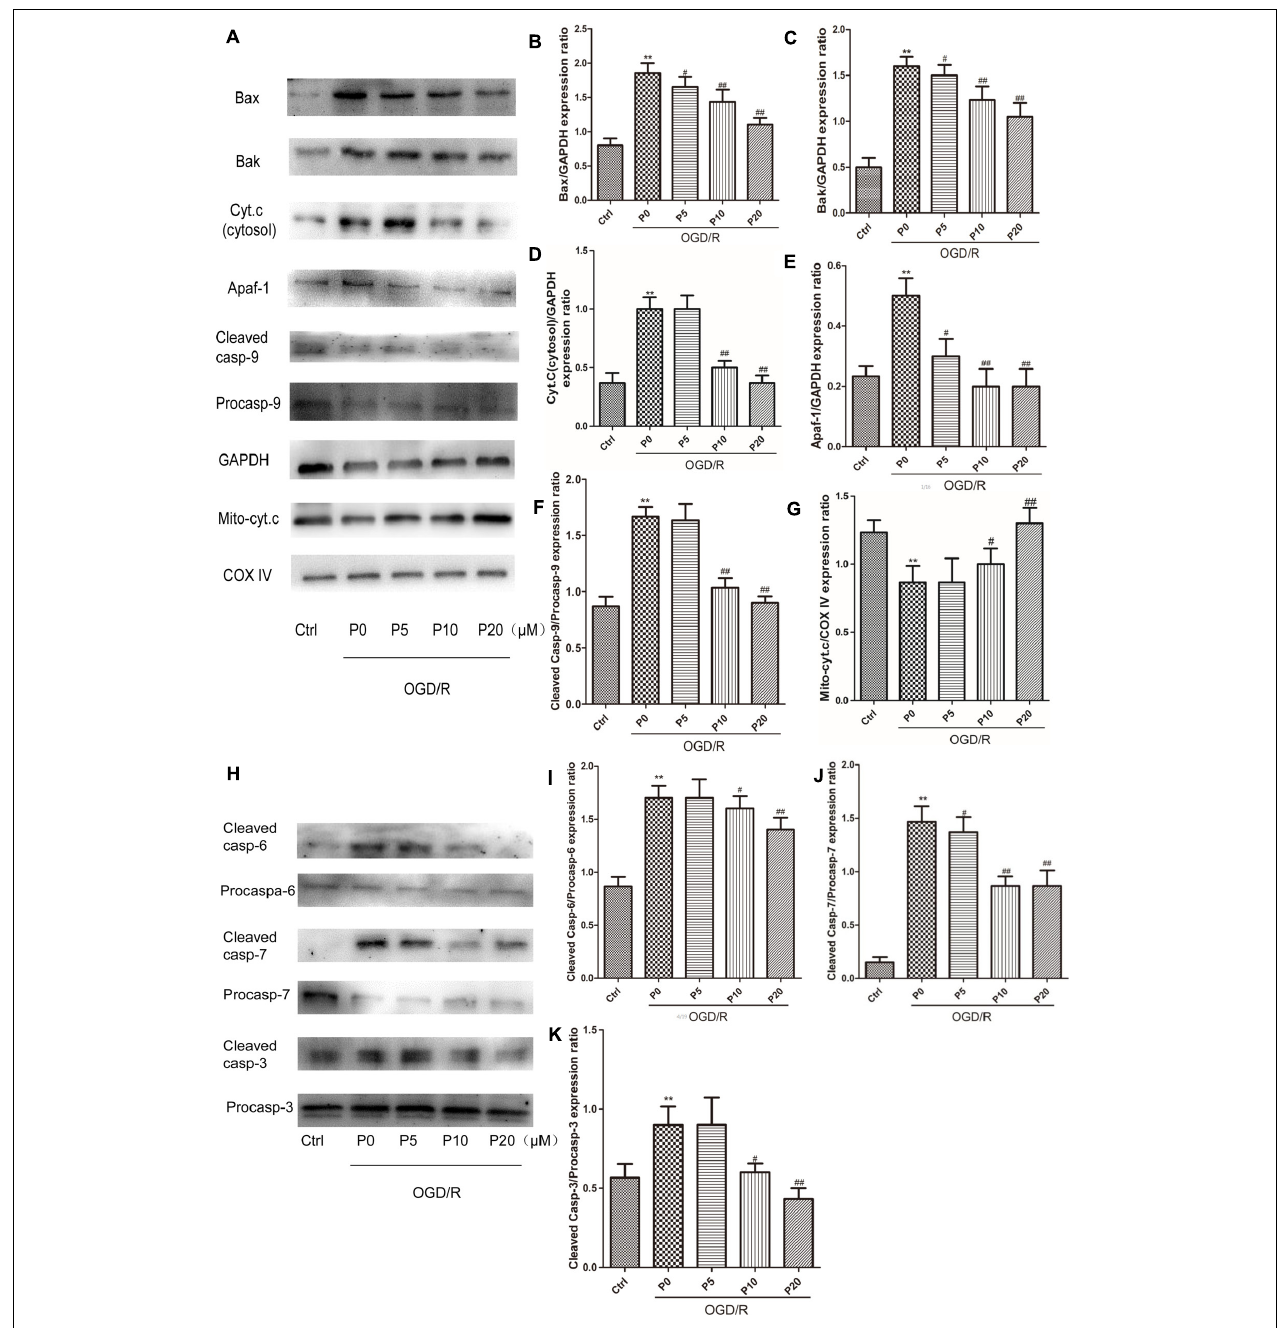
FIGURE 7 | Propofol ameliorated H9c2 cells apoptosis during OGD/R via inhibiting intrinsic apoptosis pathway. (A,H) Representative bands of Bax, Bak, cytosol cytochrome c, Apaf-1, caspase-9, mitochondrial cytochrome c, caspase-6, caspase-7, and caspase-3 by western blotting. (B,C,E,J) With the increase of propofol concentration (5, 10, 20 µ M), the levels of Bax, Bak, Apaf-1, and Cleaved caspase-7 were gradually reduced during OGD/R injury. (D,F,I,K) While the levels of cytosol cytochrome c, Cleaved caspase-9, Cleaved caspase-6 and Cleaved caspase-3 were markedly inhibited by 10 and 20 µ M propofol during OGD/R injury. (G) And with the increase of propofol concentration (10, 20 µ M), the level of mitochondrial cytochrome c protein was obviously elevated during OGD/R injury. The data are presented as the mean ± SD of at least three independent experiments. ∗∗ P < 0.01 versus control, # P < 0.05, ## P < 0.01 versus OGD/R group without propofol.